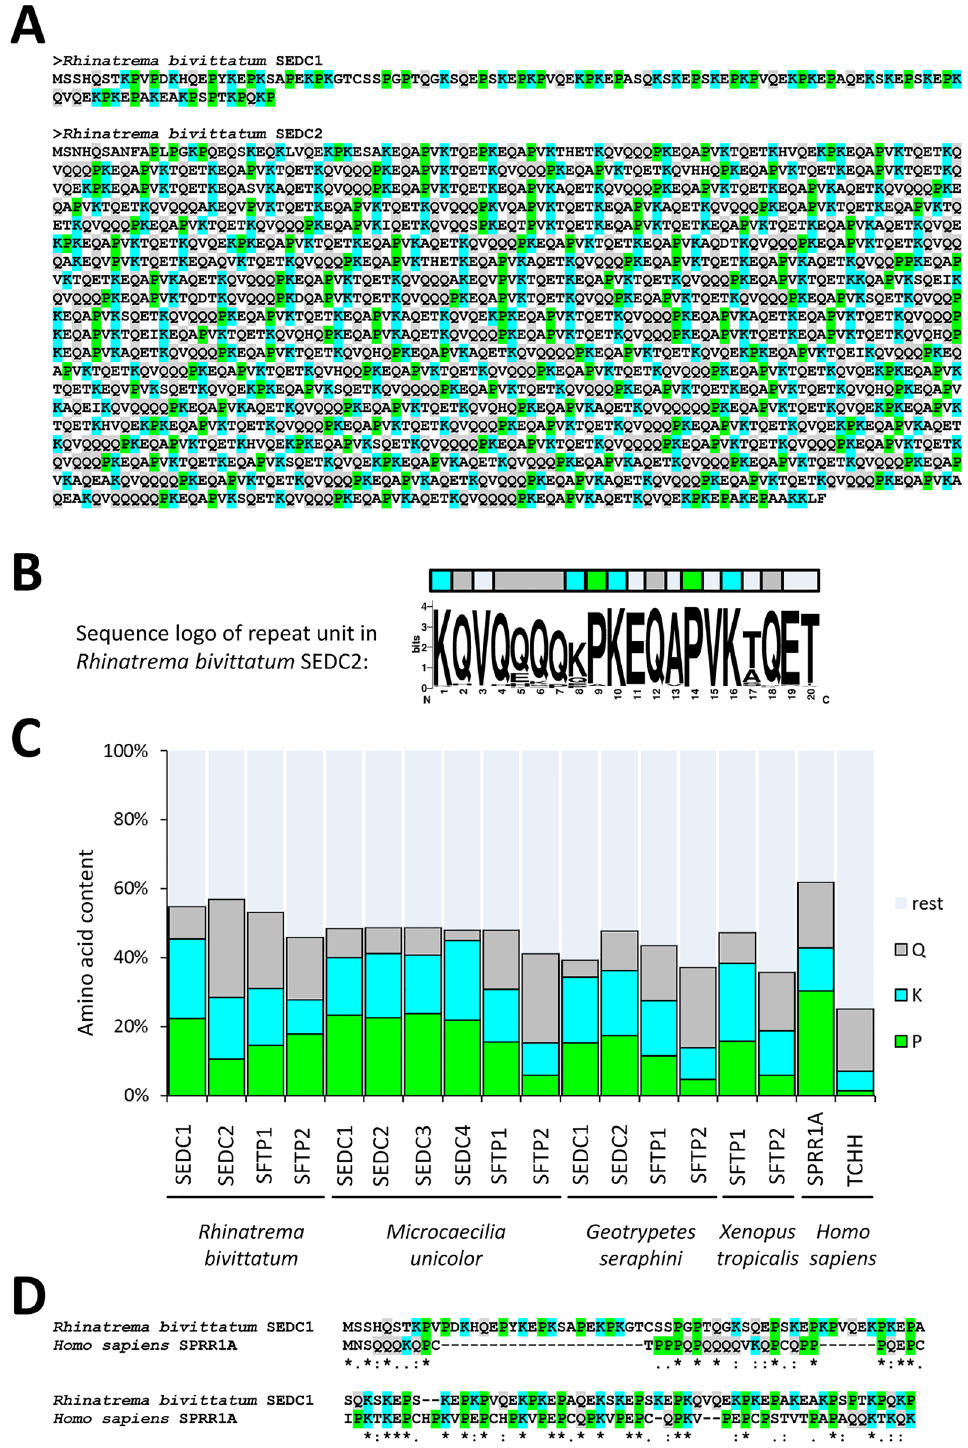
Figure 3. Amino acid sequences of caecilian EDC proteins are rich in glutamine, lysine and proline. ( A ) Amino acid sequences of Rhinatrema bivittatum SEDC proteins. ( B ) Sequence logo of the repeat unit in Rhinatrema bivittatum SEDC2 based on the alignment of repeats shown in Supplementary Fig. S2. ( C ) Amino acid contents of EDC proteins of caecilians and Xenopus tropicalis . For comparison, the values for two human EDC proteins (SPRR1A, an SEDC protein, GenBank accession NP_001186757.1, and trichohyalin, TCHH, an SFTP, GenBank accession number NP_009044.2) are shown on the right. ( D ) Amino acid sequence alignment of Rhinatrema bivittatum SEDC1 and human SPRR1A. Glutamine, lysine and proline residues are highlighted by grey, blue and green shading,